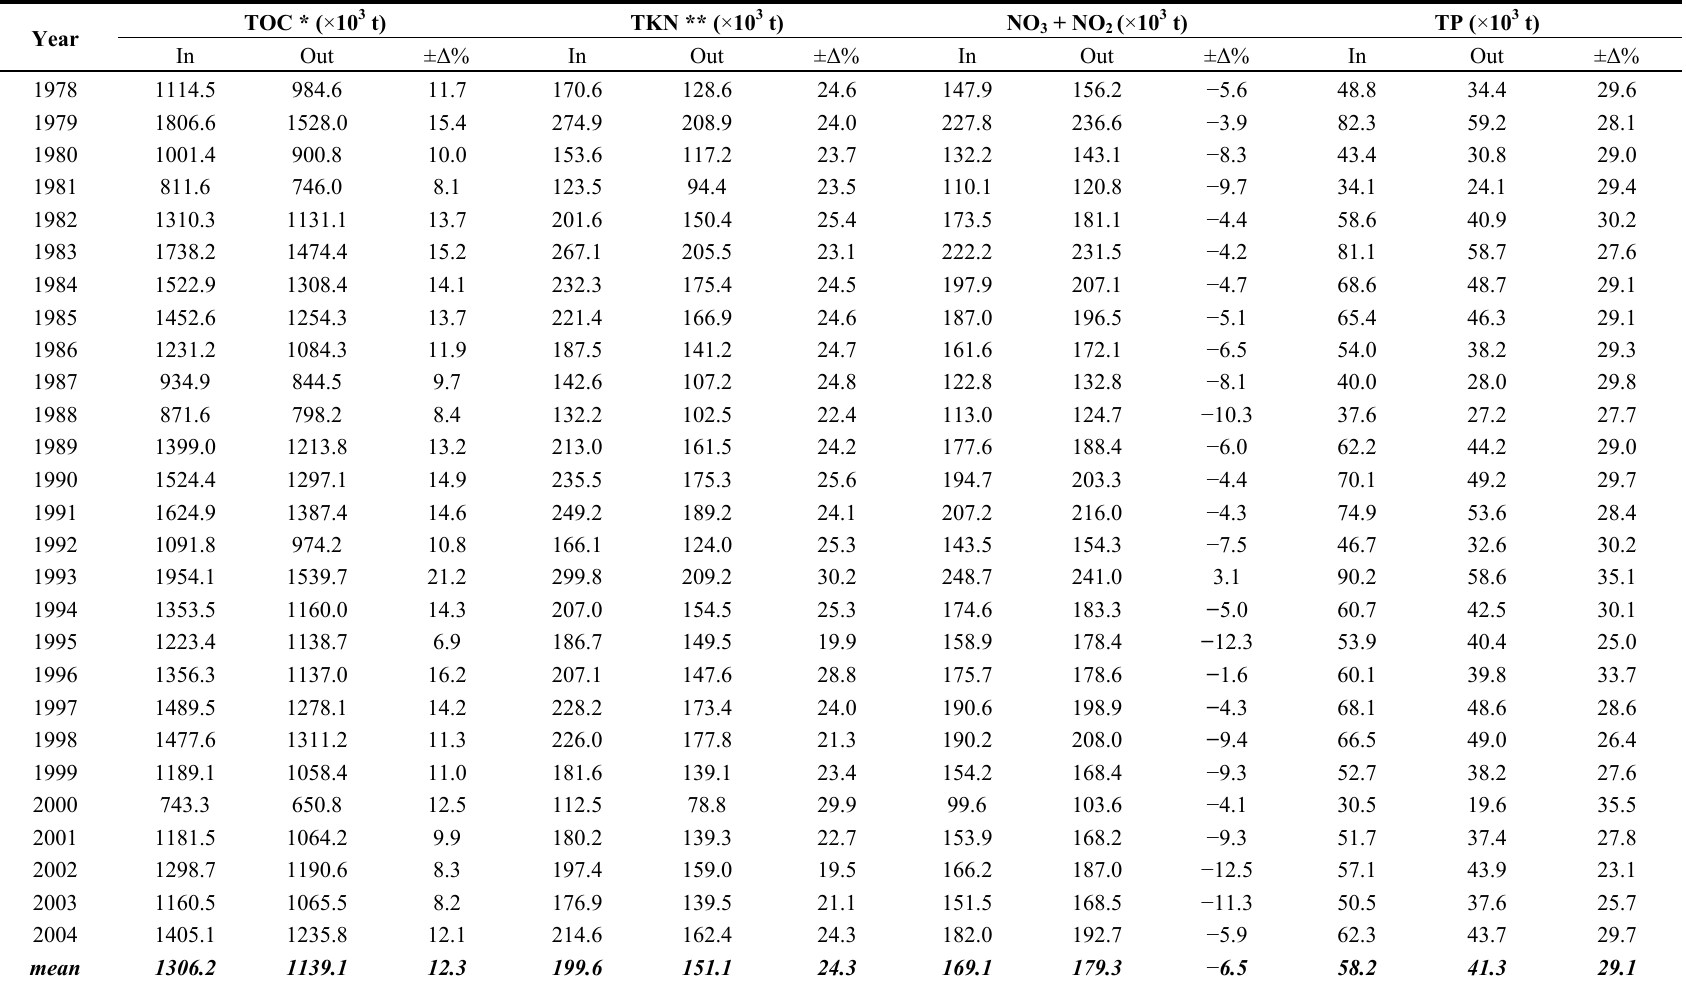
Table 3. Annual inflow–outflow budgets of total organic carbon (TOC), total Kjeldahl nitrogen (TKN), nitrate and nitrite nitrogen + NO ), and total phosphorus (TP) for the Atchafalaya River (NO 2 3